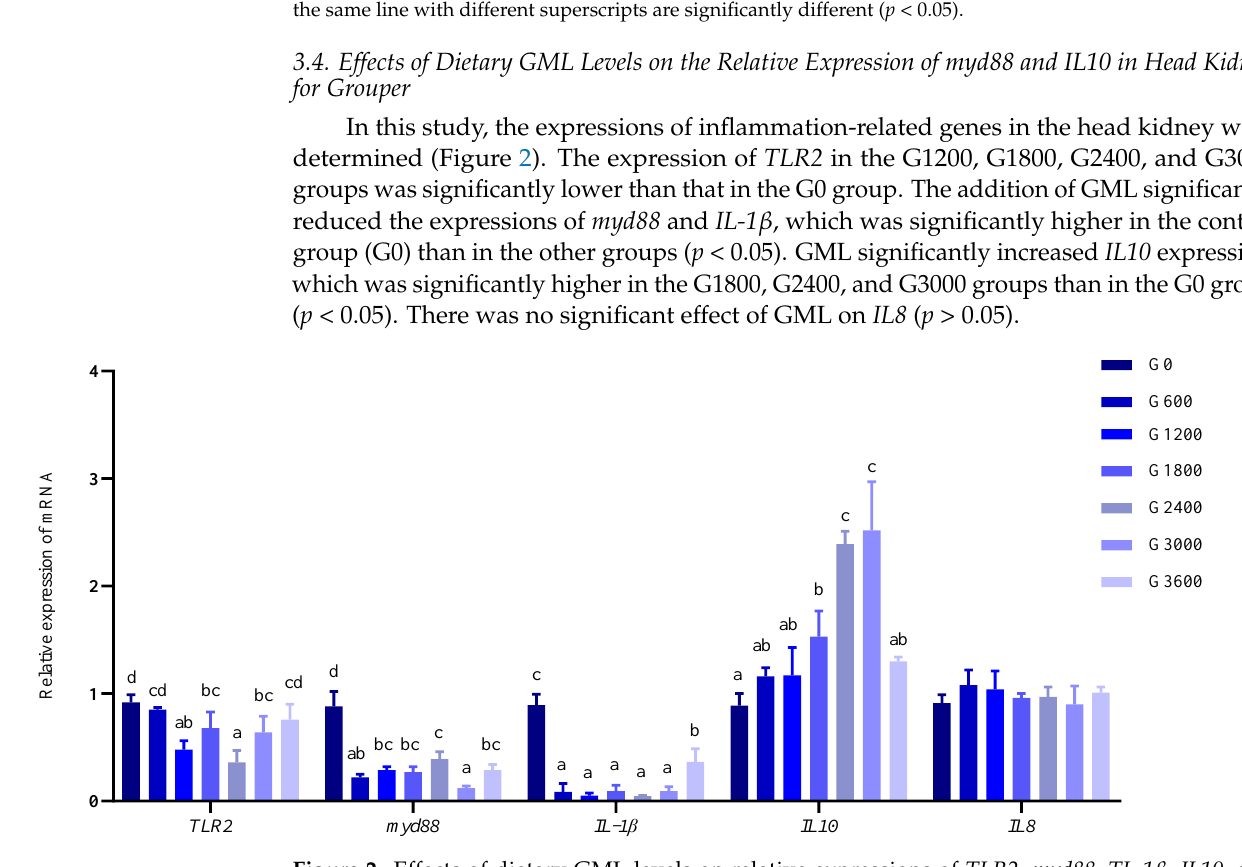
Figure 3. Effects of dietary GML levels on survival rate in bacterial challenge test for juvenile grouper. Data represent means of three tanks in each group; error bar indicates S.D. Values had different letters are significantly different ( p < 0.05). 3.5.2. Effects of Dietary GML Levels on Enzyme Activity of LZM in Bacterial Challenge Test The activity of LZM in the G600, G1800, and G2400 groups was significantly in- creased in the bacterial experiment test ( p < 0.05) and had the highest value in the G1800 group ( p < 0.05) (Figure 4A).